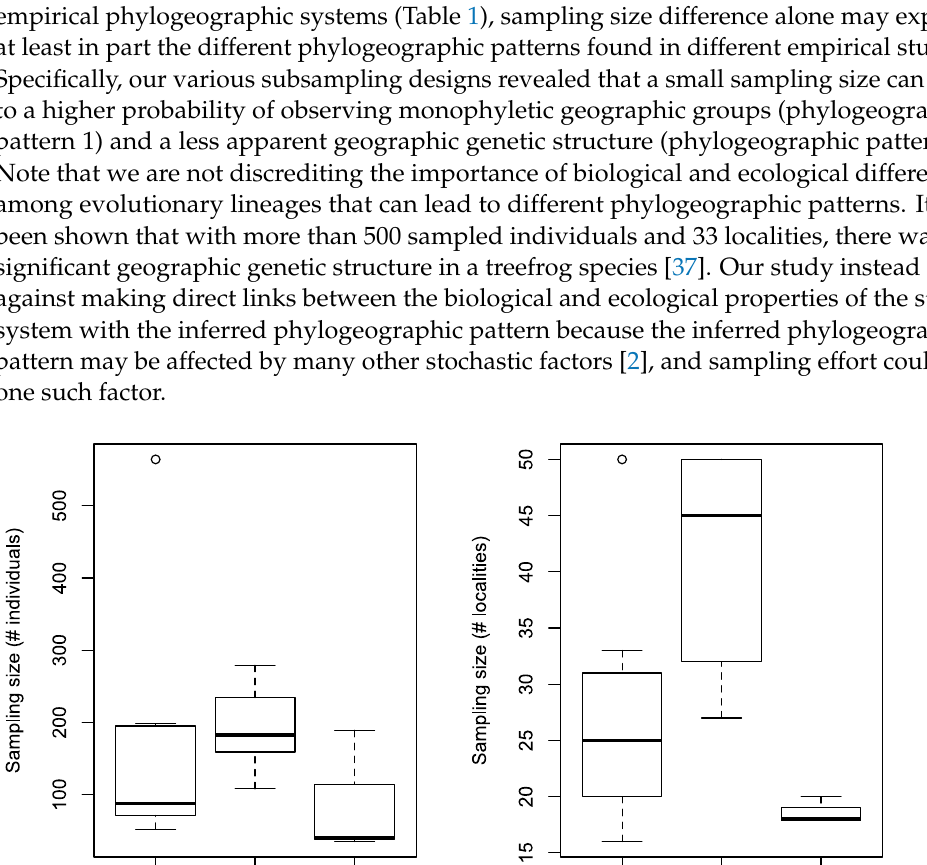
Figure 7. Summary of sampling sizes, i.e., number of individuals and number of localities, from selected empirical phylogeographic studies that resulted in different evolutionary inferences. 1. Studies that showed monophyletic geographic populations. 2. Studies that revealed significant genetic differentiation between geographic populations. 3. Studies that inferred panmictic geographic populations.